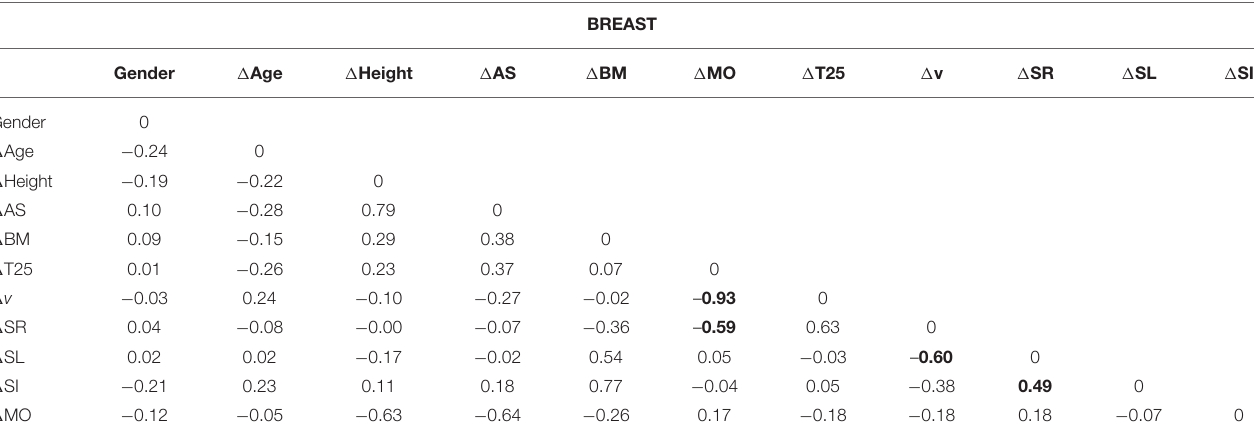
TABLE 2 | The weight matrix for the BREAST with the 1 % (gender as a dichotomous variable) ( n = 20).